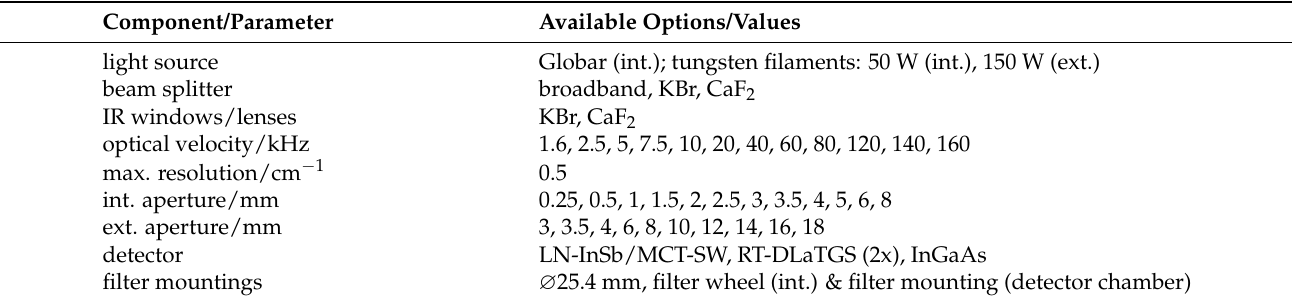
Table 1. Currently available optical components and options